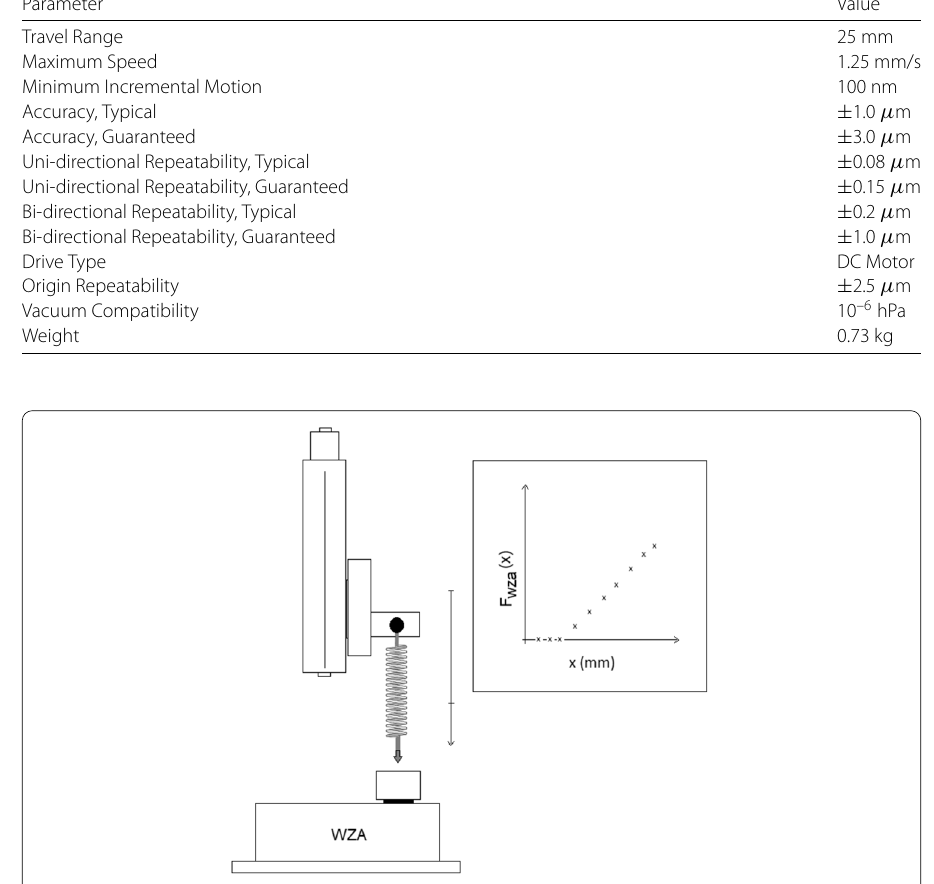
Figure 11 Setup for calibration the spring. A WZA load cell is used in its ordinary position (horizontal) and the motion stage pushed the spring against it. For simplicity sake we still show a wound wire spring. After